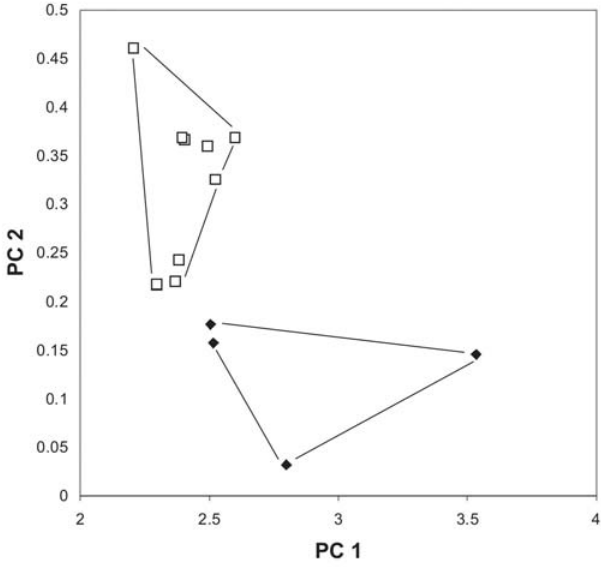
Fig. 6. Principal component analysis (PC1 vs . sheared PC2) of combined samples of Microglanis maculatus (black diamonds; n = 4) and M. robustus (light squares; n =